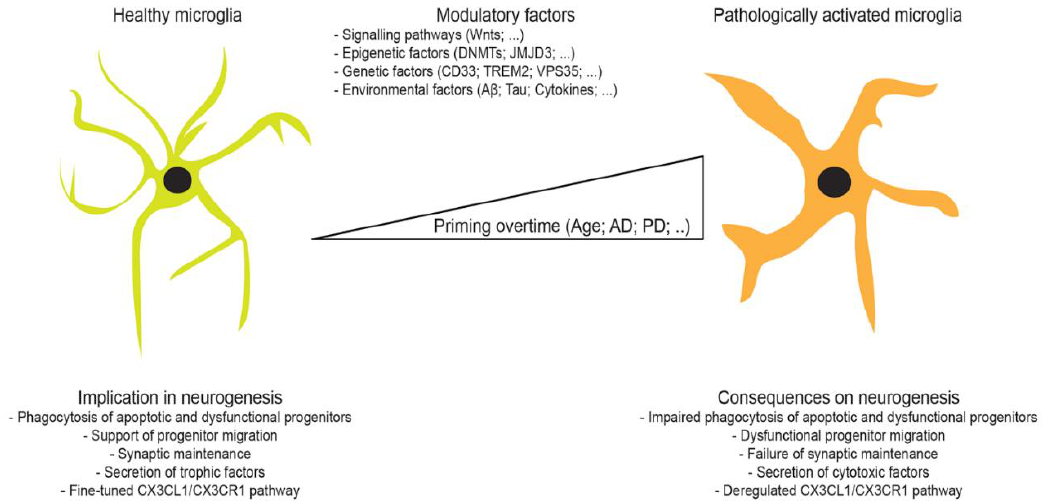
Figure 1. Microglia regulation of neurogenesis during lifespan: In the young healthy brain, microglia actively modulate neurogenesis via several supportive mechanisms that ensure the proper turnover of adult newly born neurons. A plethora of modulatory factors dictate microglial functions, and thereby influencing the rate of adult neurogenesis. Over age, microglia become less mobile, adopt an amoeboid-like phenotype, chronically express pro-inflammatory cytokines, and display an impaired phagocytic activity. The age-dependent establishment of a pro-inflammatory phenotype is accompanied by the release of neurotoxic cytokines, which impairs neurogenesis and synaptic integrity, and thereby contributing to neuronal loss and cognitive decline seen in Alzheimer’s disease (AD), and Parkinson’s disease ( PD).